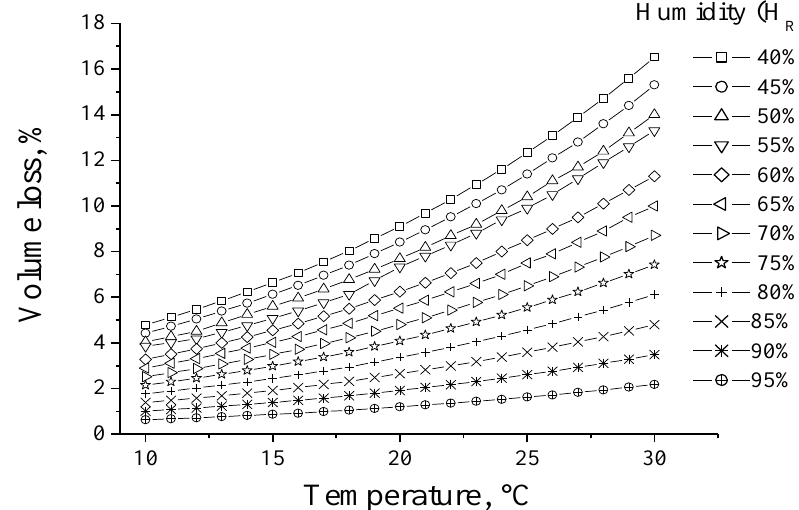
Figure 1. Volume loss for evaporation during ageing as function of the temperature at constant relative air humidity ( H R in %). Ethanol content of the spirit: (40% v / v). White oak standard barrels of 205 L (+/ − 10 L).